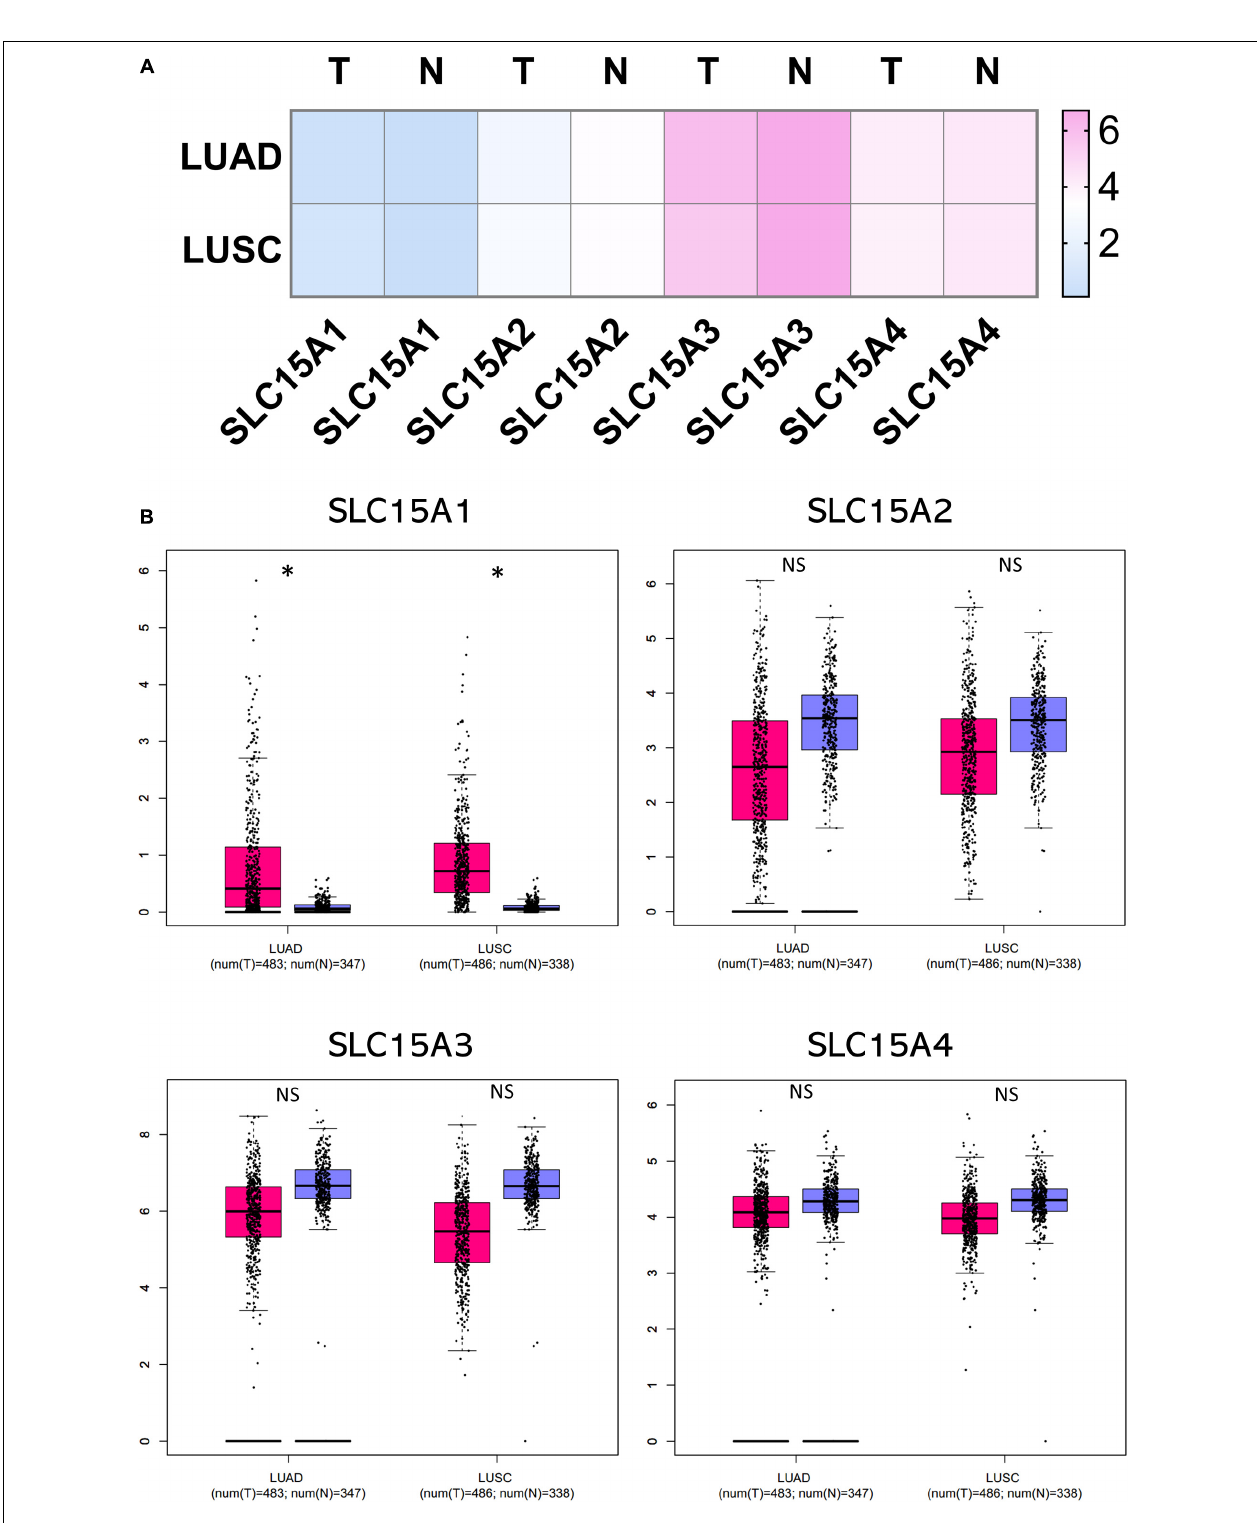
FIGURE 2 | Comparison of normalized SLC15A family member expression levels in tumor samples vs. normal tissue. The cancer abbreviation name is shown according to TCGA study abbreviation (LUAD = lung adenocarcinoma; LUSC = lung squamous cell carcinoma). (A) Heatmap of SLC15A family relative expression after normalization by log2(TPM + 1) for log-scale. T, tumor; N, normal tissue. Light blue indicates lower expression and pink color is for relative higher expression across the SLC15A family. (B) Box plot of RNA-seq expression details for individual patients and average. The Y axis is using TPM. Pink is for the tumor samples, and purple is for the normal lung tissue. T, tumor (Pink); N, normal tissue (Purple); NS, not statistically significant. ∗ P value <